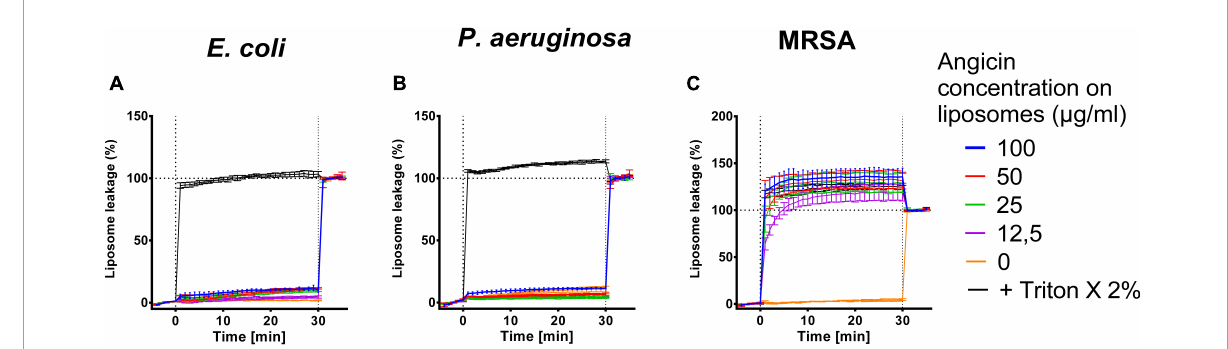
FIGURE3 Effect of Angicin on bacteria derived liposomes. Liposomes filled with 50 mM carboxyfluorescein formed from bacterial lipid extracts either commercially purchased ( E. coli , Avanti Lipids, A ), or extracted from live bacteria [ P. aeruginosa (B) , methicillin resistant Staphylococcus aureus, MRSA (C) ] by the Folch method were added to 96-well plates and baseline fluorescence was recorded once per minute for 5 min in total once per minute. Angicin was then added at indicated concentrations and fluorescence increase (indicating membrane disruption) was recorded for 30 min with one measurement per minute. Triton X-100 was then added to all wells at 2% final concentration to induce total lysis. Background signal was subtracted (signal of liposome prior to addition of compounds) and normalized to fluorescent signal achieved in each well after complete liposome leakage induced by addition of 2% (v/v) Triton X-100. Depicted is the mean of three experiments ± standard